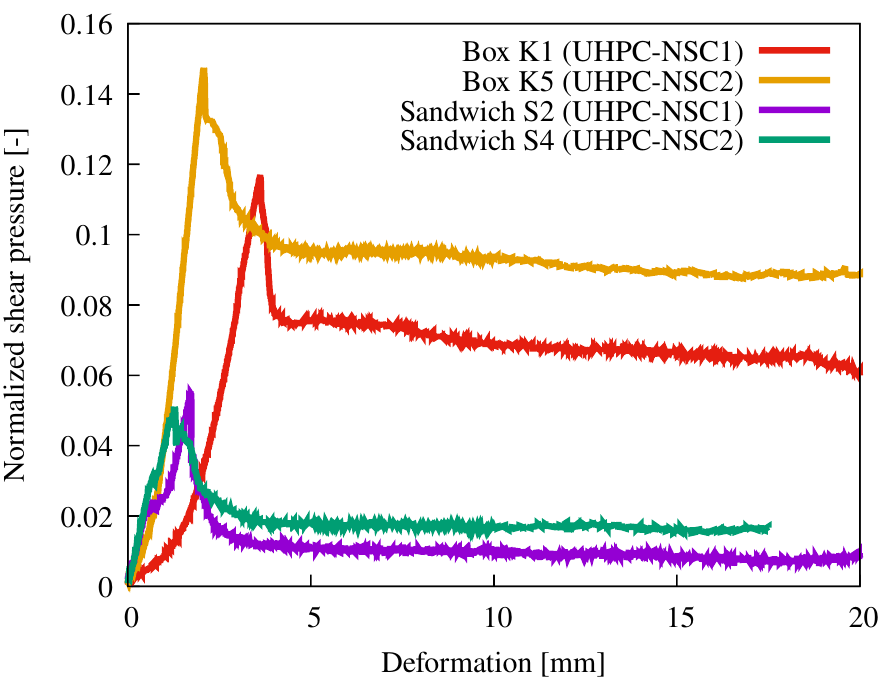
Figure 12. Graphs of normalized shear pressure vs. deformation according to Figure 11. The shear strength was normalized by the average compressive strength measured on cubes, see Table